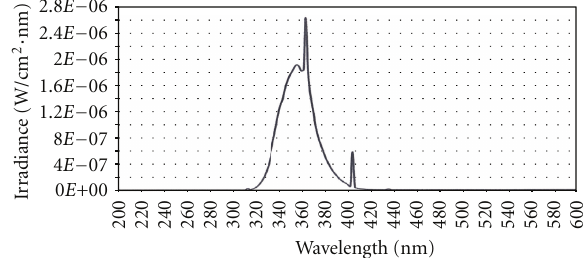
Figure 1: Irradiation spectrum of the UVA lamp used in this